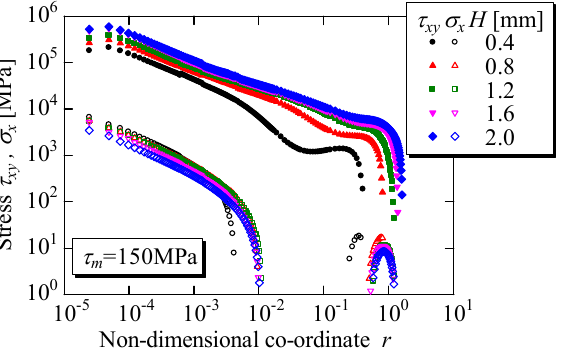
Figure 13. Shear and tensile stress distributions for various specimen heights under constant average shear stress condition of τ m = 150 MPa.